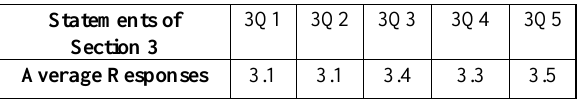
Table 6. The summary for TP responses to Section 3